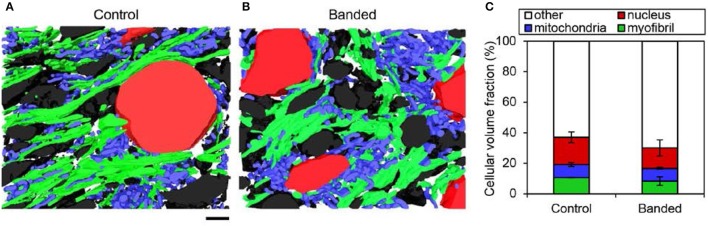
FIB-SEM organelle volume quantitation summary. Example 3D myocardium segmentation reconstructions from a control (A) and banded (B) embryonic heart with myofibril, mitochondrial, nuclear, and extracellular material displayed in green, blue, red, and black, respectively. (C) Average cellular volume fraction quantification from 3D reconstructions (n = 3 per group), where there were no significant differences of any cellular component between banded and control samples. Scale bar = 2 μm.